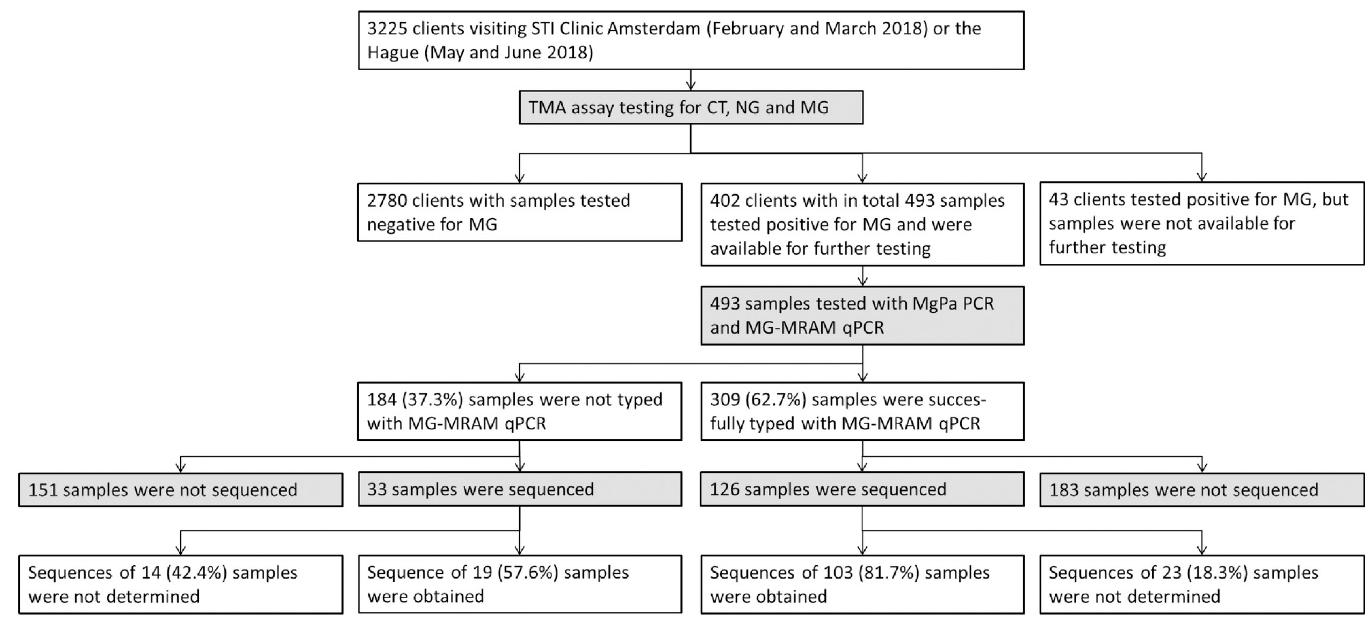
Fig 1. Flow diagram summarizing the number of clients and samples included in this study and which tests were performed on which samples.